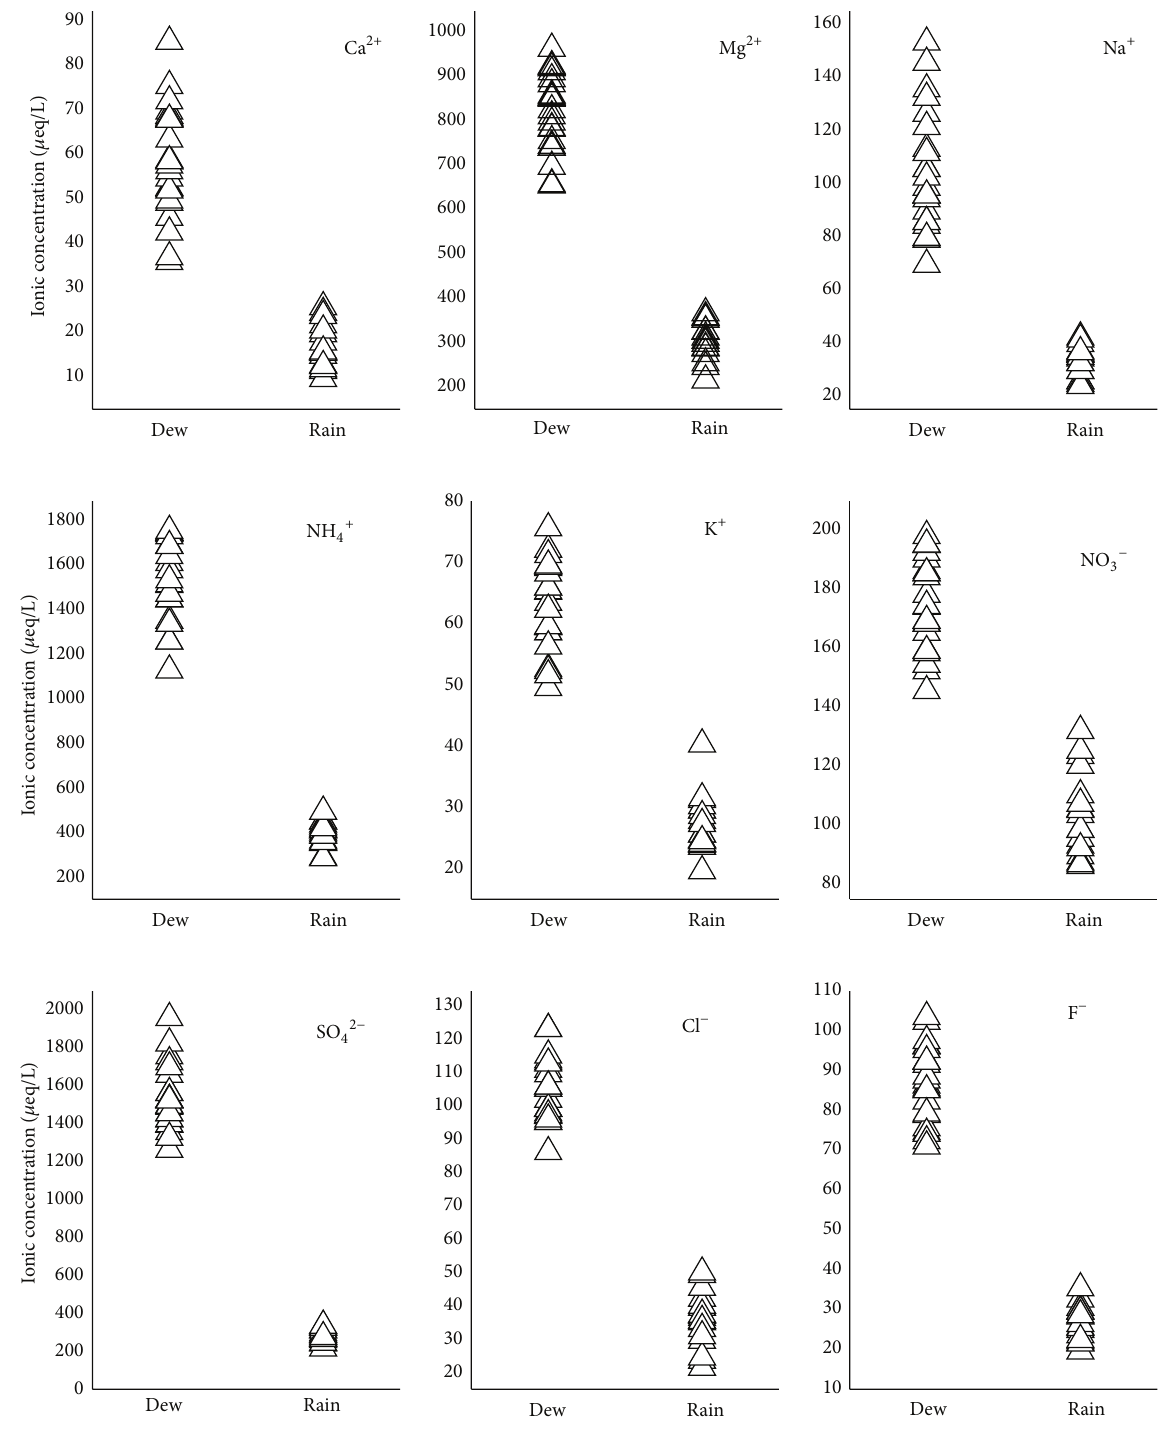
Figure 2: The ionic concentration of NH 4+ , Mg 2+ , Ca 2+ , K + , Na + , Cl − , NO 3− , F − , and SO 42− of rain and dew in Changchun.